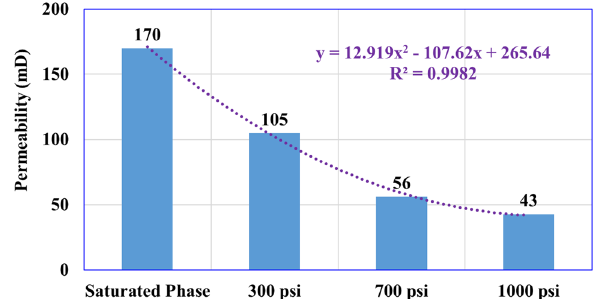
Figure 8. Permeability reduction versus the applied overbalance